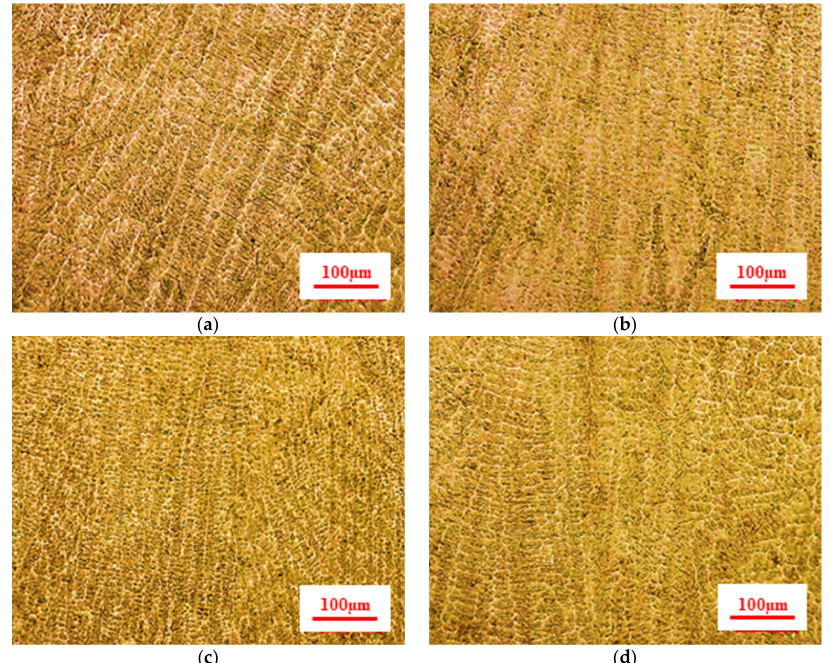
Figure 12. Microstructure of the weld pass with different linear energy densities: ( a ) WS: 200 mm/min